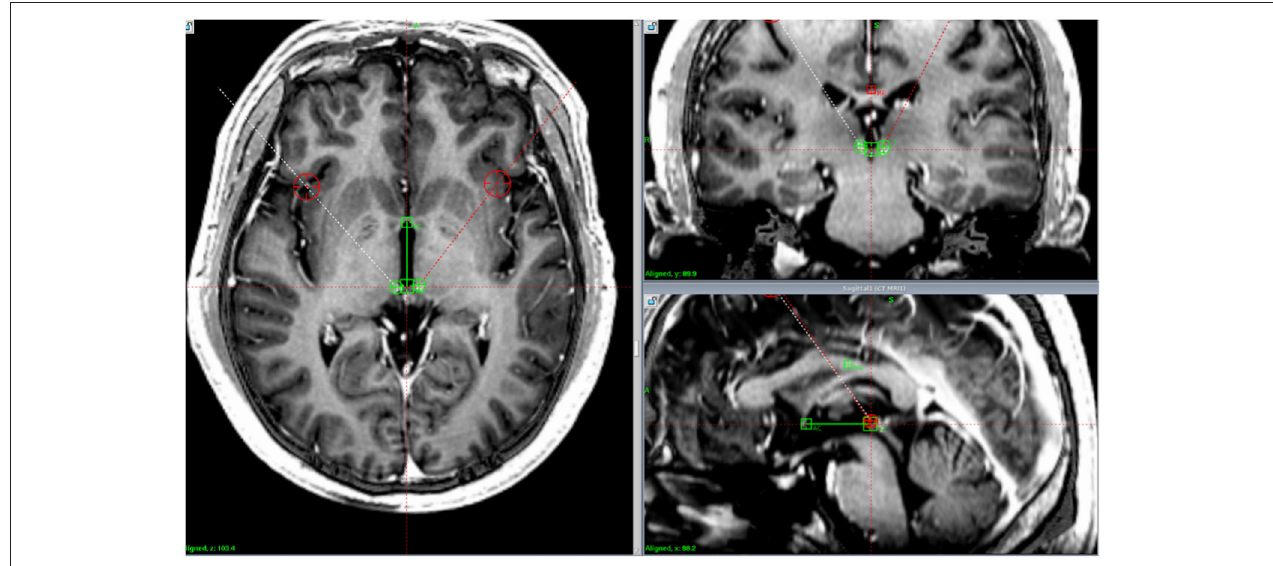
FIGURE 1 | Lead location. Postoperative computed tomography images fused with preoperative magnetic resonance imaging demonstrating the position of the implanted electrodes in the habenula in one patient.